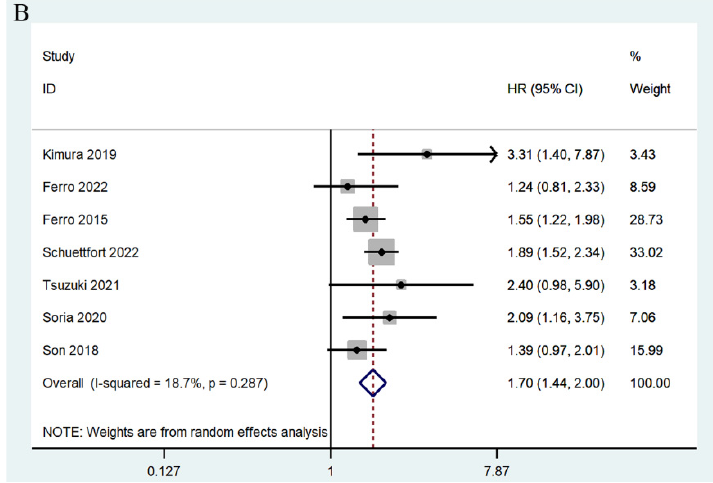
Figure 5. Forest plots of relationship between mGPS and RFS in patients with urothelial carcinoma: ( A ) mGPS 1 vs. 0; ( B ) mGPS 2 vs. 0 [17,24,25,27,28,31,33].